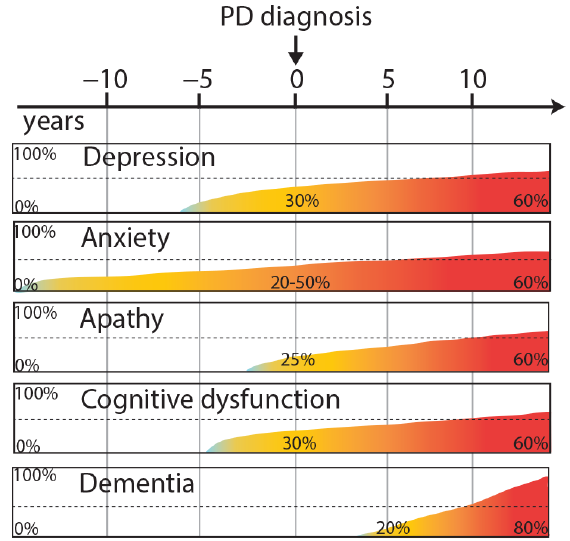
Figure 1. Overview neuropsychiatric and cognitive symptoms in PD, illustrating their approximate progression and temporal relationships with the onset of motor symptoms.